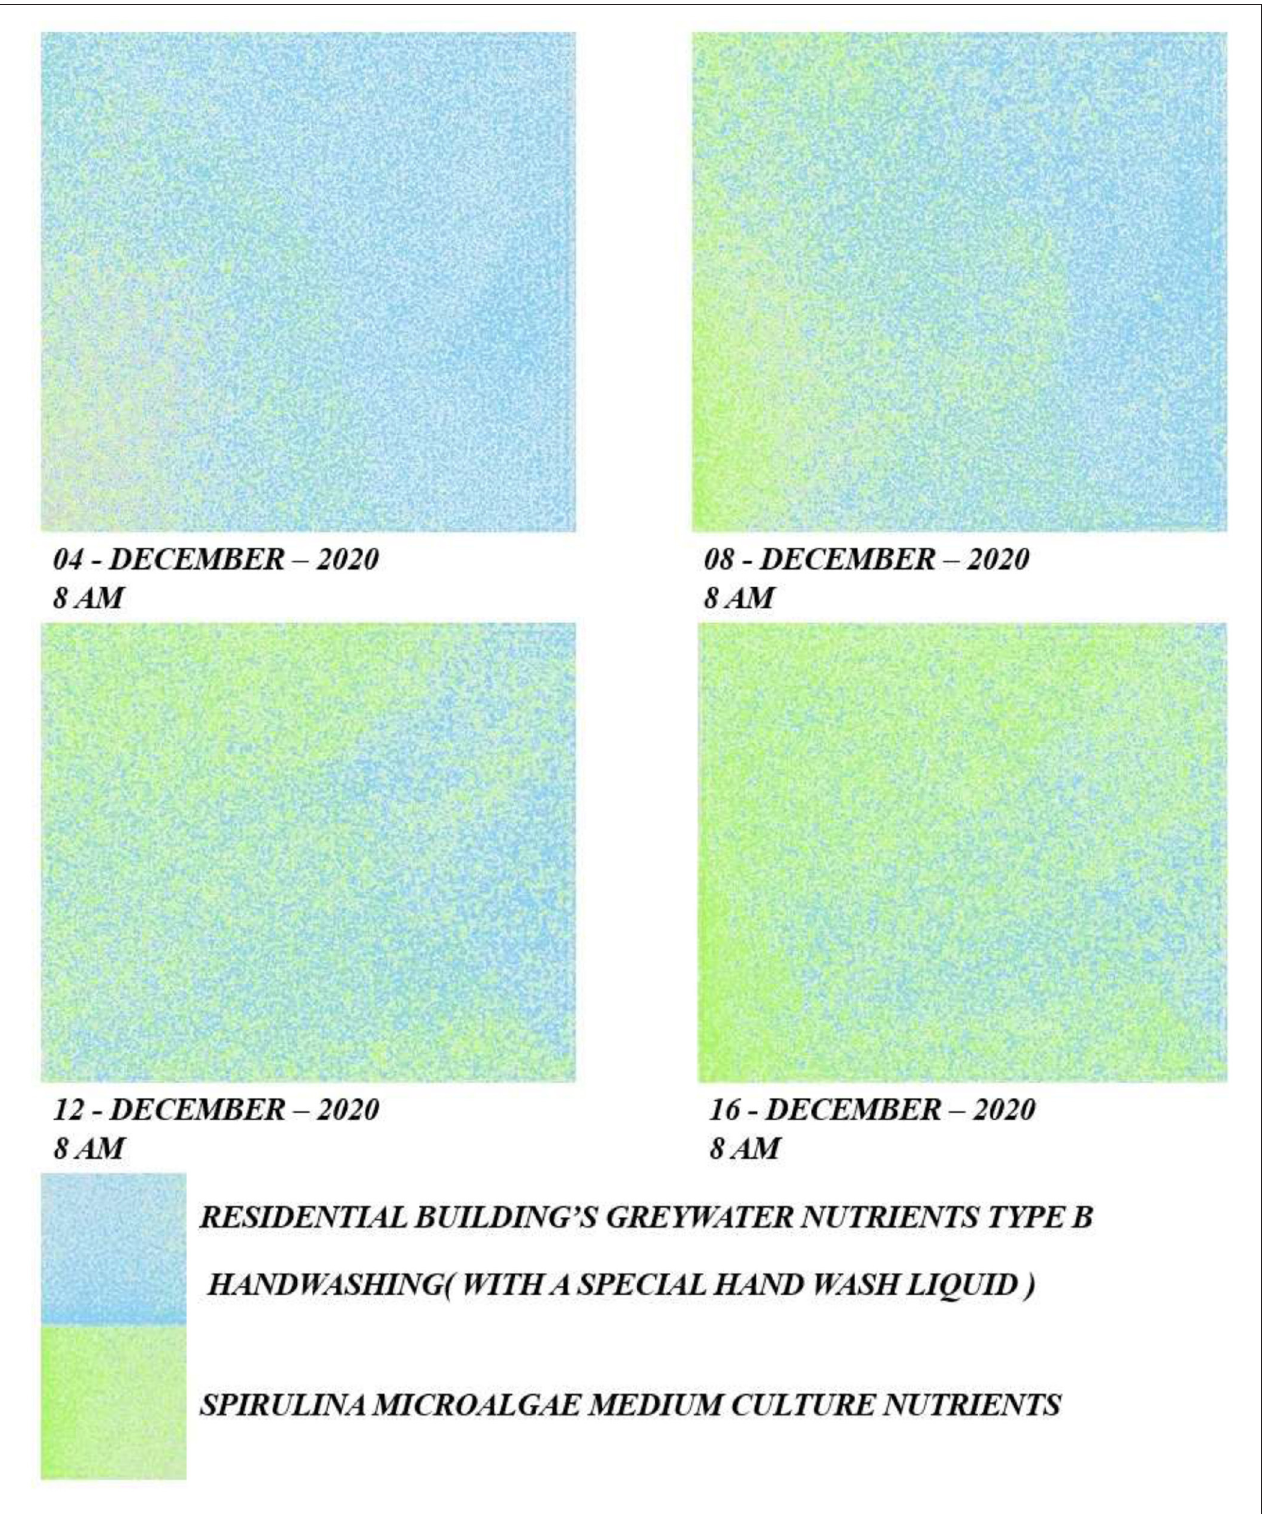
FIGURE 9 | Growth density of microalgae simulation in the hybrid tank-material type B.